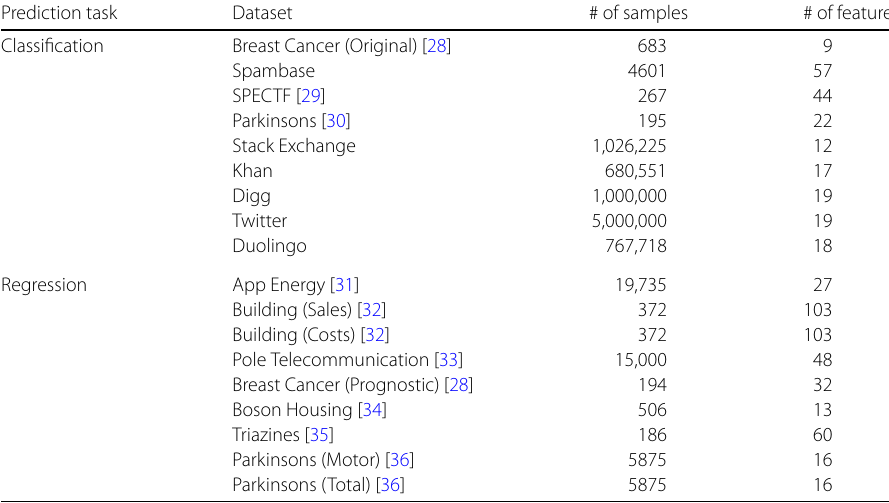
Table 1 Datasets Used for Performance Comparison Prediction